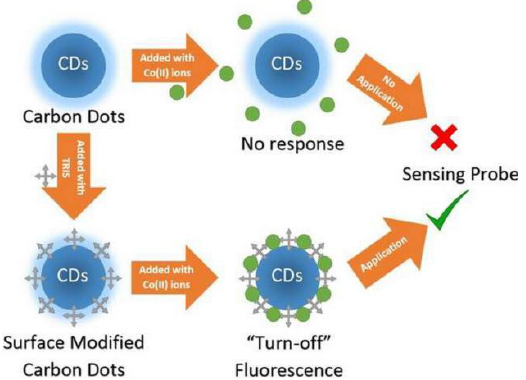
Figure 1. Schematic illustration of synthesis process of CDs and their application to Co 2+ detection. Adapted with permission from Ng et al., 2018, copyright 2018. Reproduced with permission from Elsevier [23].